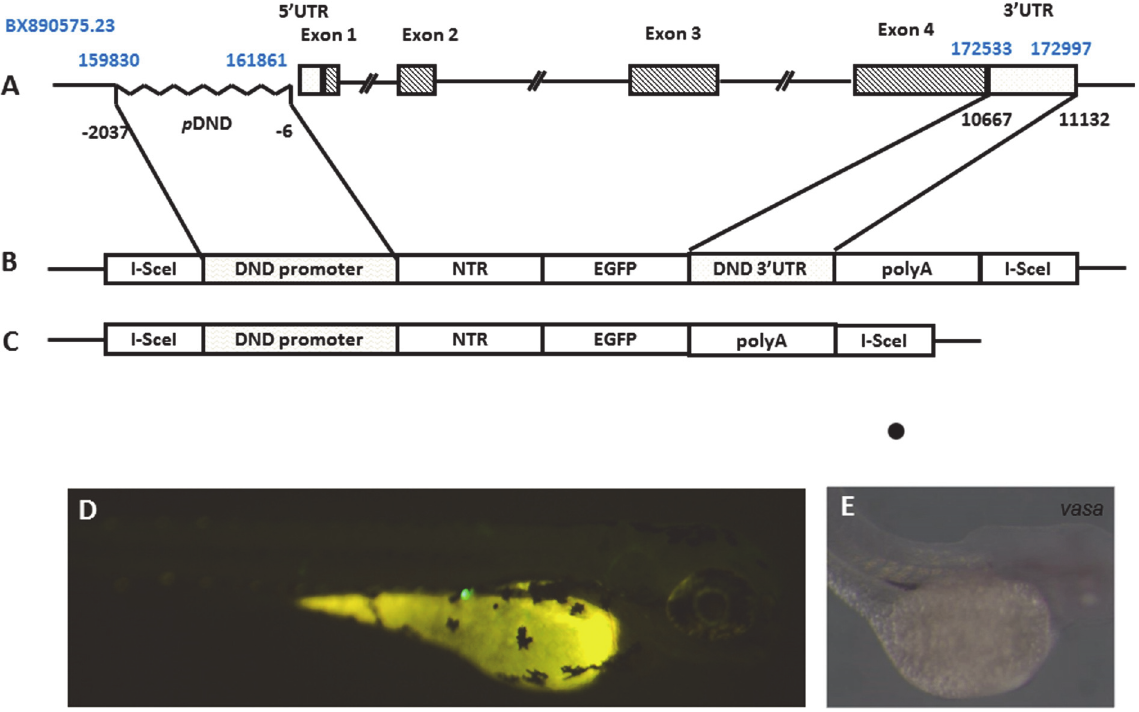
Fig 1. Generation of the transgenic zebrafish with the NTR-EGFP expression under the control of zebrafish dnd promoter. A) genomic structure of zebrafish dnd gene, including 5 ’ UTR region, 4 exons and 3 ’ UTR region identified for its PGC-specific presence in the fourth exon. The positions for the region in zebrafish DNA sequence BX890575.23 are labeled in blue. The position sites for the region used related to the transcriptional starting site of dnd are labeled in black. B) schematic representation of the transgenic construct containing the 5 ’ - dnd : ntr-egfp-3 ’ UTR of dnd- 3 ’ fragment flanked by I-Sce1 sites. C) Schematic representation of the transgenic construct containing the 5 ’ - dnd : ntr-egfp without dnd- 3 ’ fragment flanked by I-Sce1 sites. D) Fluorescence microscopic image showing EGFP-expressing PGCs of a F0 progeny at 72 hpf. E) in situ hybridization signals of vasa probe showing the position of PGC at 72